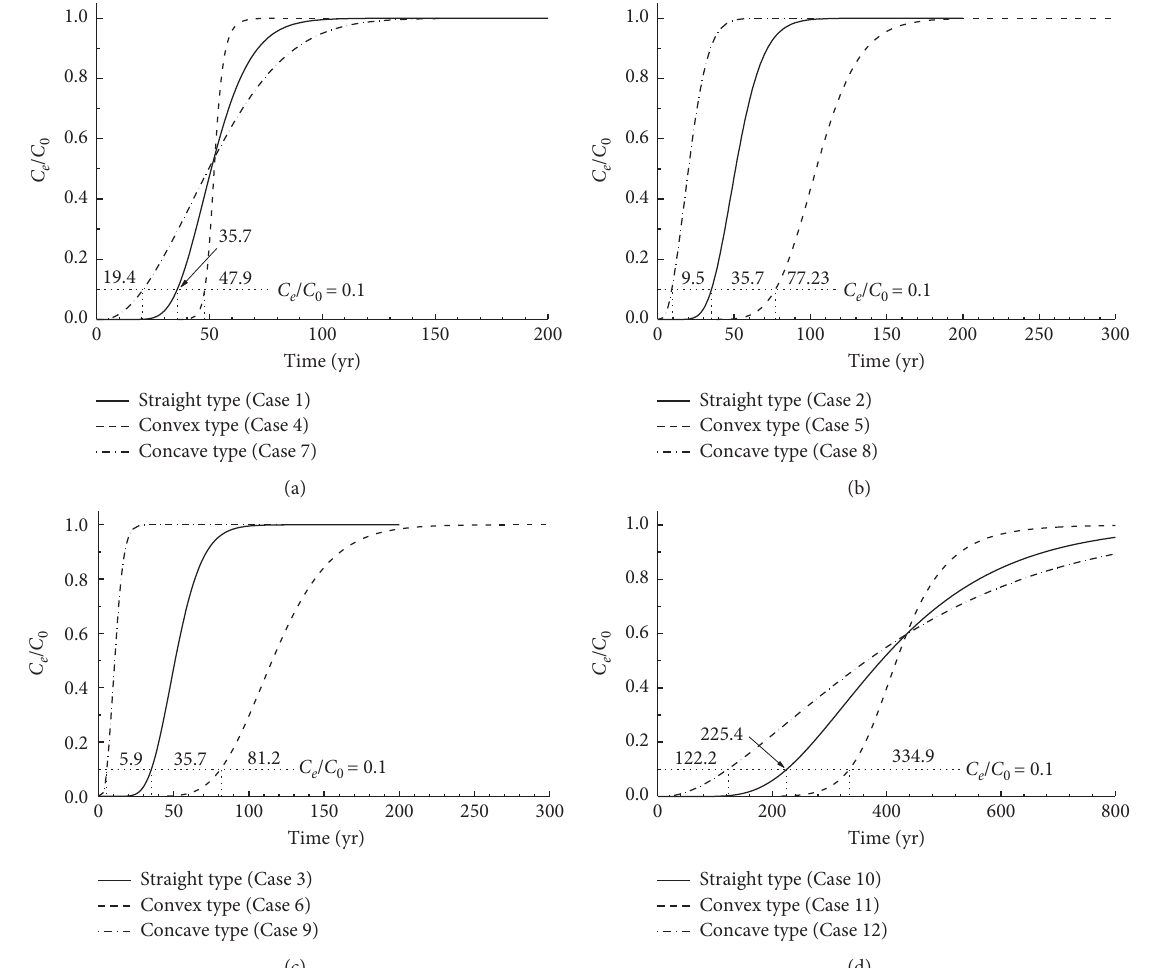
� 1000mg/L). (b) Cases 2, 5, 8 0